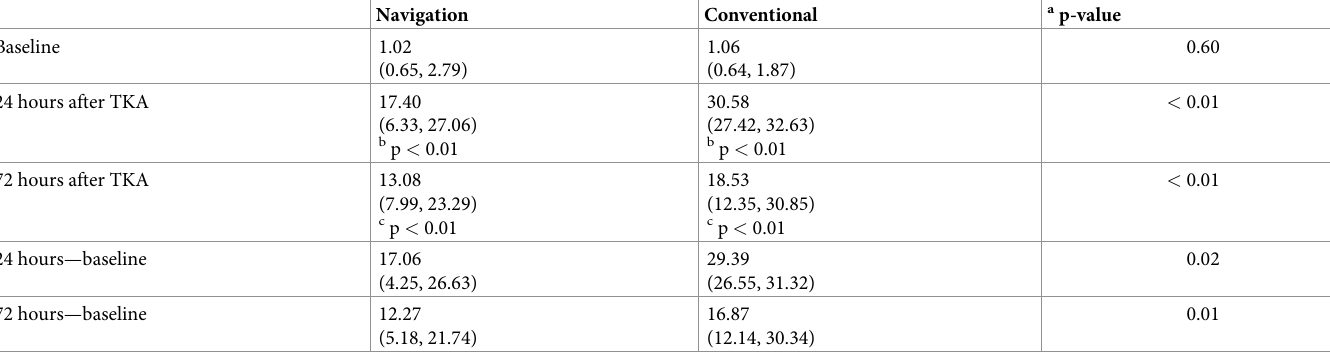
Table 2. Serum IL-6 concentrations (pg/mL) prior to TKA, then at 24 and 72 hours after